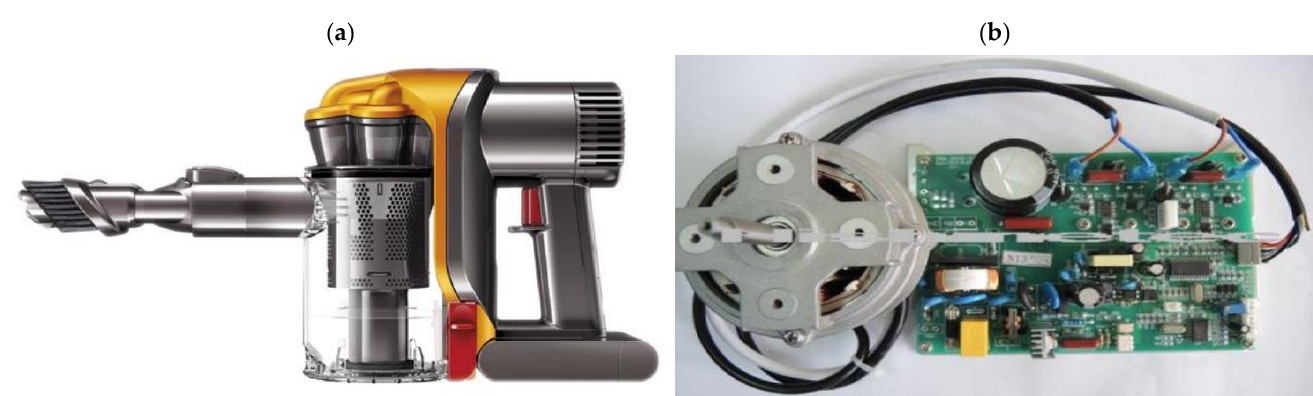
Figure 1. Applications employing switched reluctance motors: ( a ) Dyson DC31 [1]; ( b ) reluctance motor with its control system, hand dryer by Hishine [2].